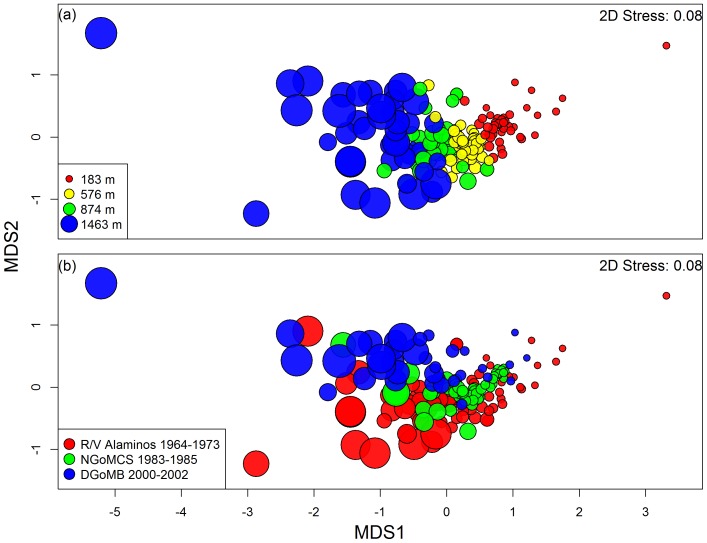
Non-metric multi-dimensional scaling (MDS) on inter-sample Sørensen’s similarities of pooled data.The distances between samples represent relative dissimilarities in species composition. (a) Symbol sizes show relative water depths with colors indicating four depth intervals with equivalent numbers of samples. (b) Symbol sizes show relative depth with colors indicating three studies of different sampling times.